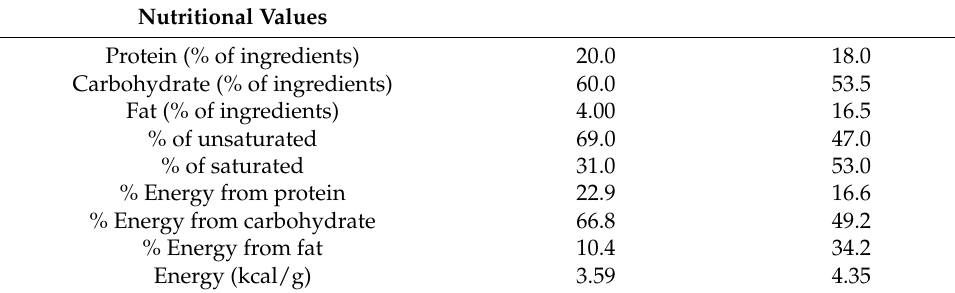
Table 1. Nutritional values of control and HSF